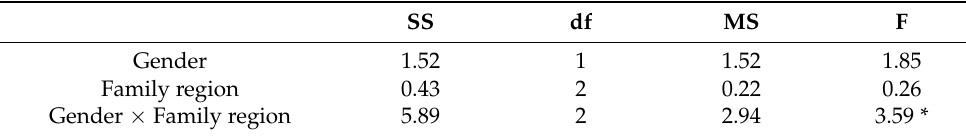
Table 8. Two-way ANOVA results of reward-oriented involution involvement with respect to gender and family region.